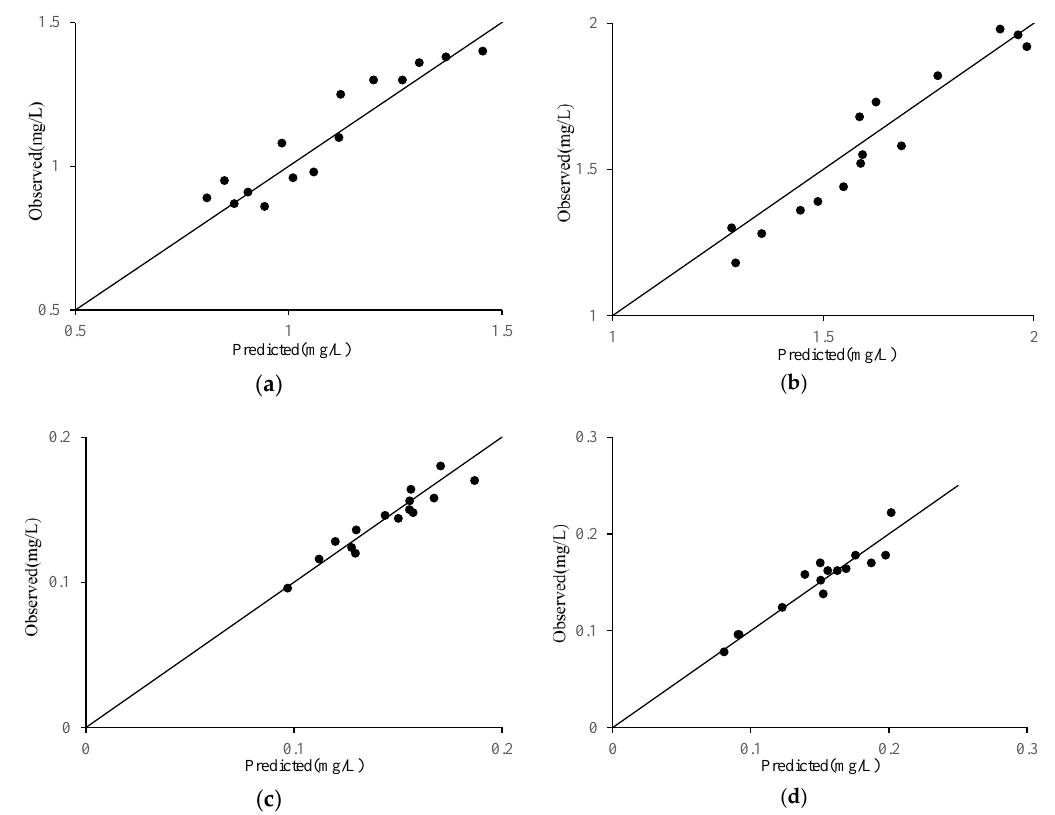
Figure 4. Validation of TN (( a ) point C; ( b ) point B) and TP (( c ) point C; ( d ) point B).